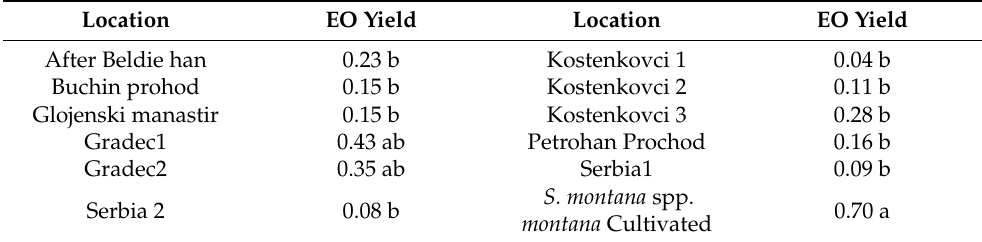
Table 3. Mean EO yield (%) of S. kitaibelii collected at 11 locations.